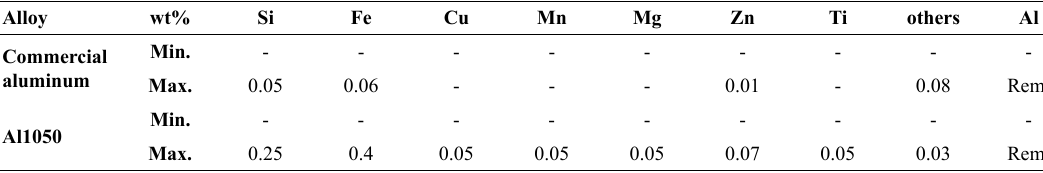
Table 2. Composition of the aluminum alloys evaluated. Alloy wt% Commercial